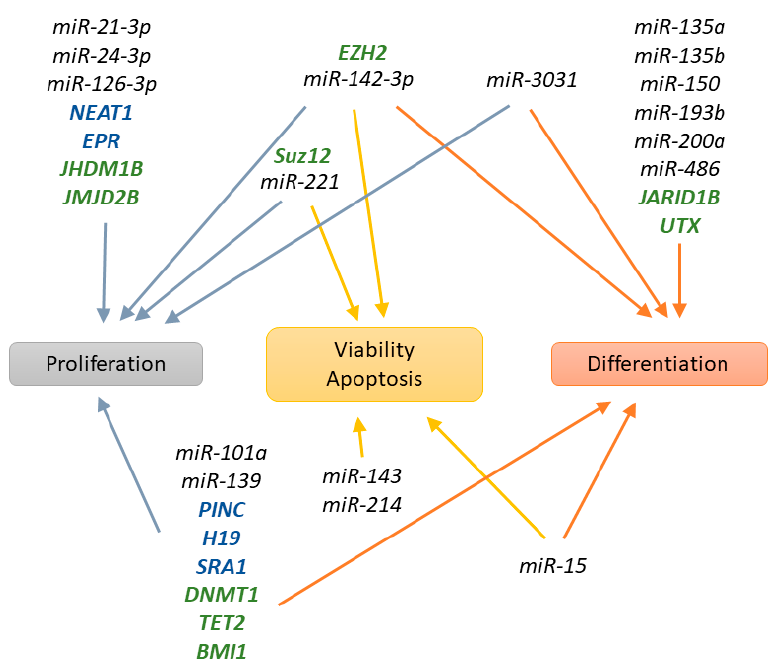
Figure 4. Cell processes modulated by epigenetic regulators: The epigenetic modulating proteins (in green), microRNAs (in black), and long non-coding RNAs (in blue) discussed in this review can be categorized based on which cell process they play a role in. Colour-coded arrows show which processes the mentioned epigenetic regulators are involved in.